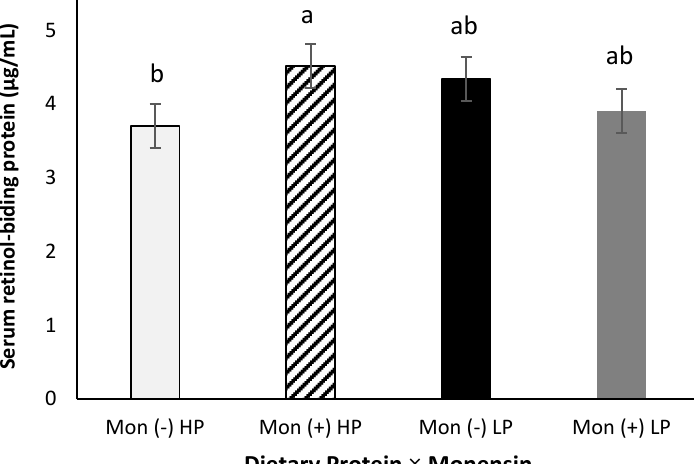
Figure 4. Serum retinol-binding protein (RBP) concentration for multiparous Holstein dairy cows ( n = 80, total) that were fed diets with crude protein levels (10.3%, n = 40 vs. 12.2% dry matter basis, n = 40), and within each crude protein group fed monensin (400 mg/day per head or none) and vitamin A (110 IU/kg body weight or none) during prepartum period (from day − 35 to the day of calving). All cows received a common lactation ration postpartum. Dietary protein × monensin ( p < 0.04). Different letters mean statistical difference between the treatments.